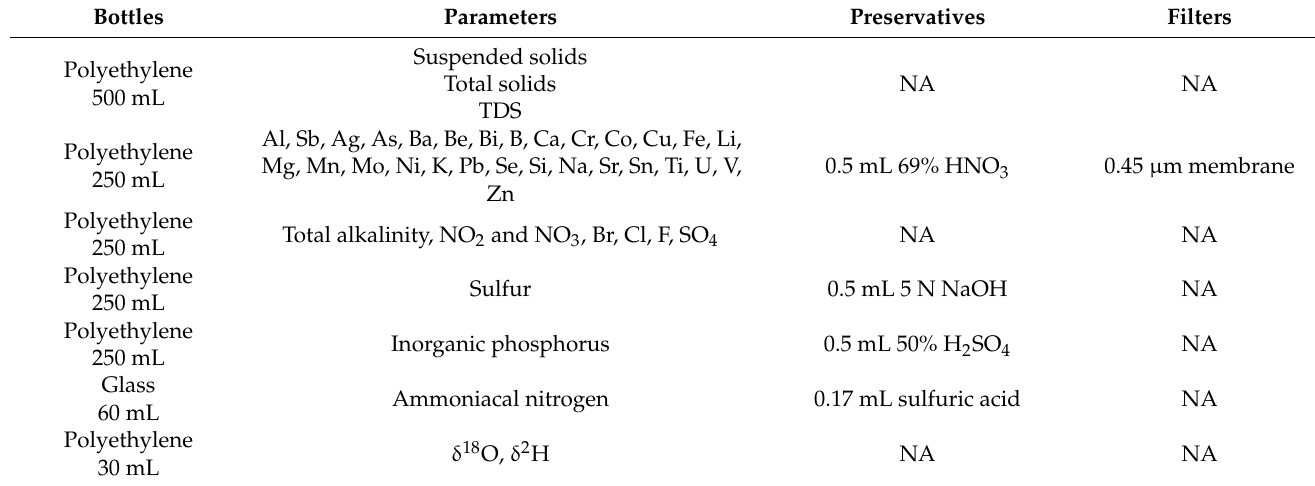
Table 1. Chemical elements analyzed by the accredited laboratory, Bureau Veritas